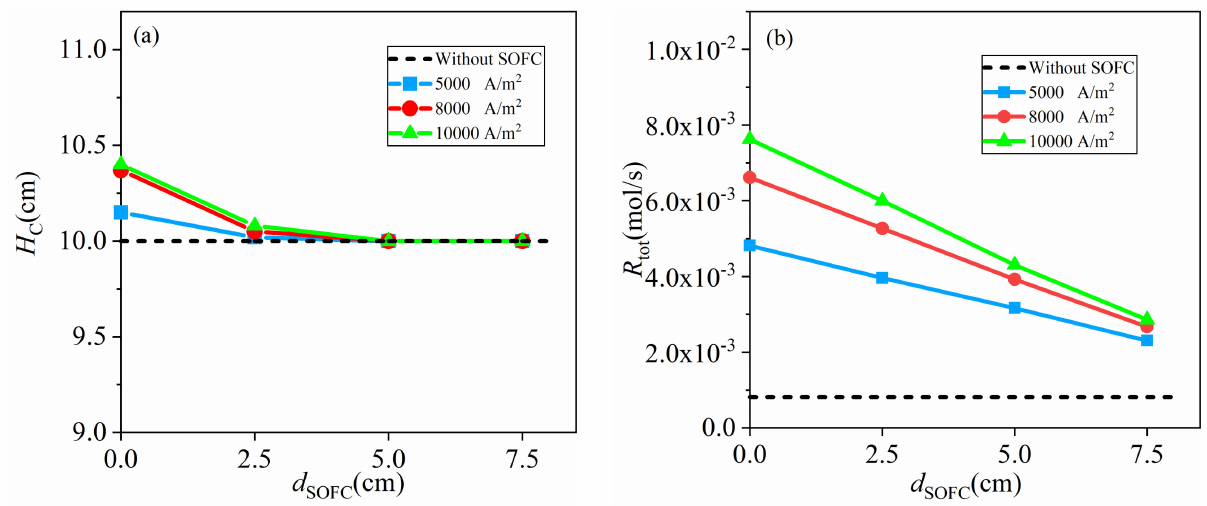
Figure 10. ( a ) Carbon bed height, H C and ( b ) total gasification rate, R tot of fluidized bed coupled with SOFC with A s = 7.2 × 10 − 5 mol/m 2 , v CO = 0.2 cm/s. 2 ,in